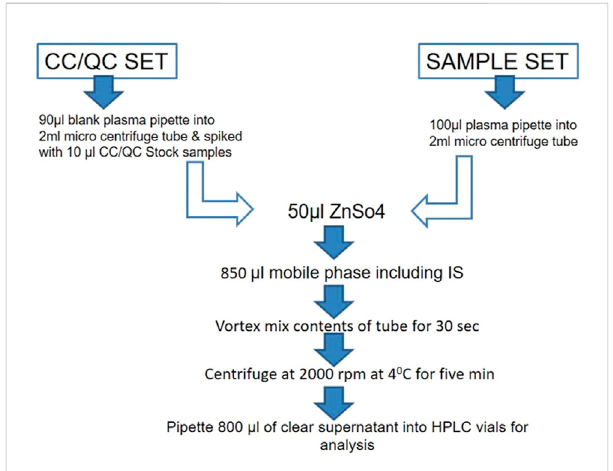
FIGURE 1 Schematic fl ow chart for the extraction of drug from the plasma by the precipitation method. The procedure was followed for all plasma samples, calibration curve samples, and QC